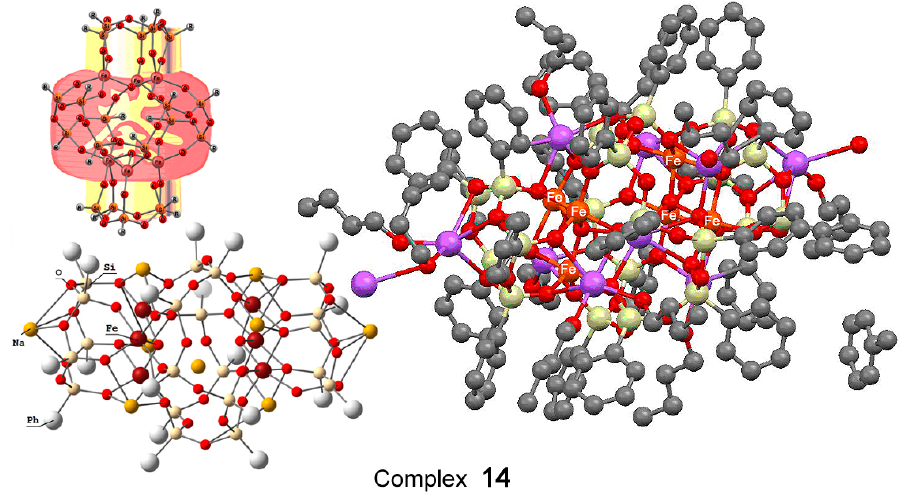
Figure 8. The structure of heteronuclear Na 8 Fe 6 ‐ oxo cluster bearing silsesquioxane ligands [(PhSiO 1.5 ) 20 (FeO 1.5 ) 6 (NaO 0.5 ) 8 (C 7 H 8 )(C 4 H 9 OH) 9 ] ( 14 ). Adapted from Ref. [225].